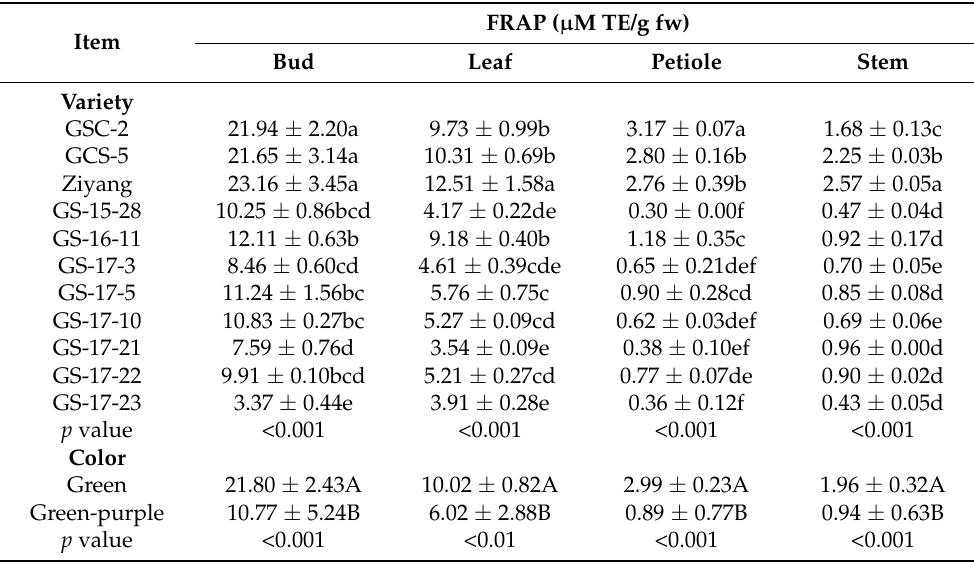
Table 4. The ferric reducing antioxidant power (FRAP) assay of buds, leaves, petioles, and stems of 11 leafy sweet potato varieties.